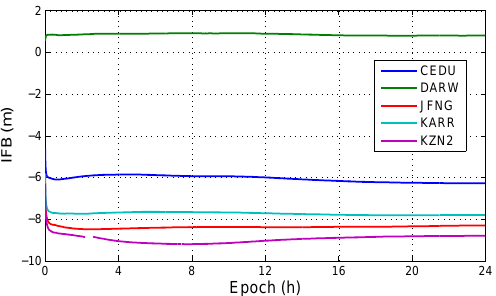
Figure 5. IFB at different stations in DOY 100, 2018.